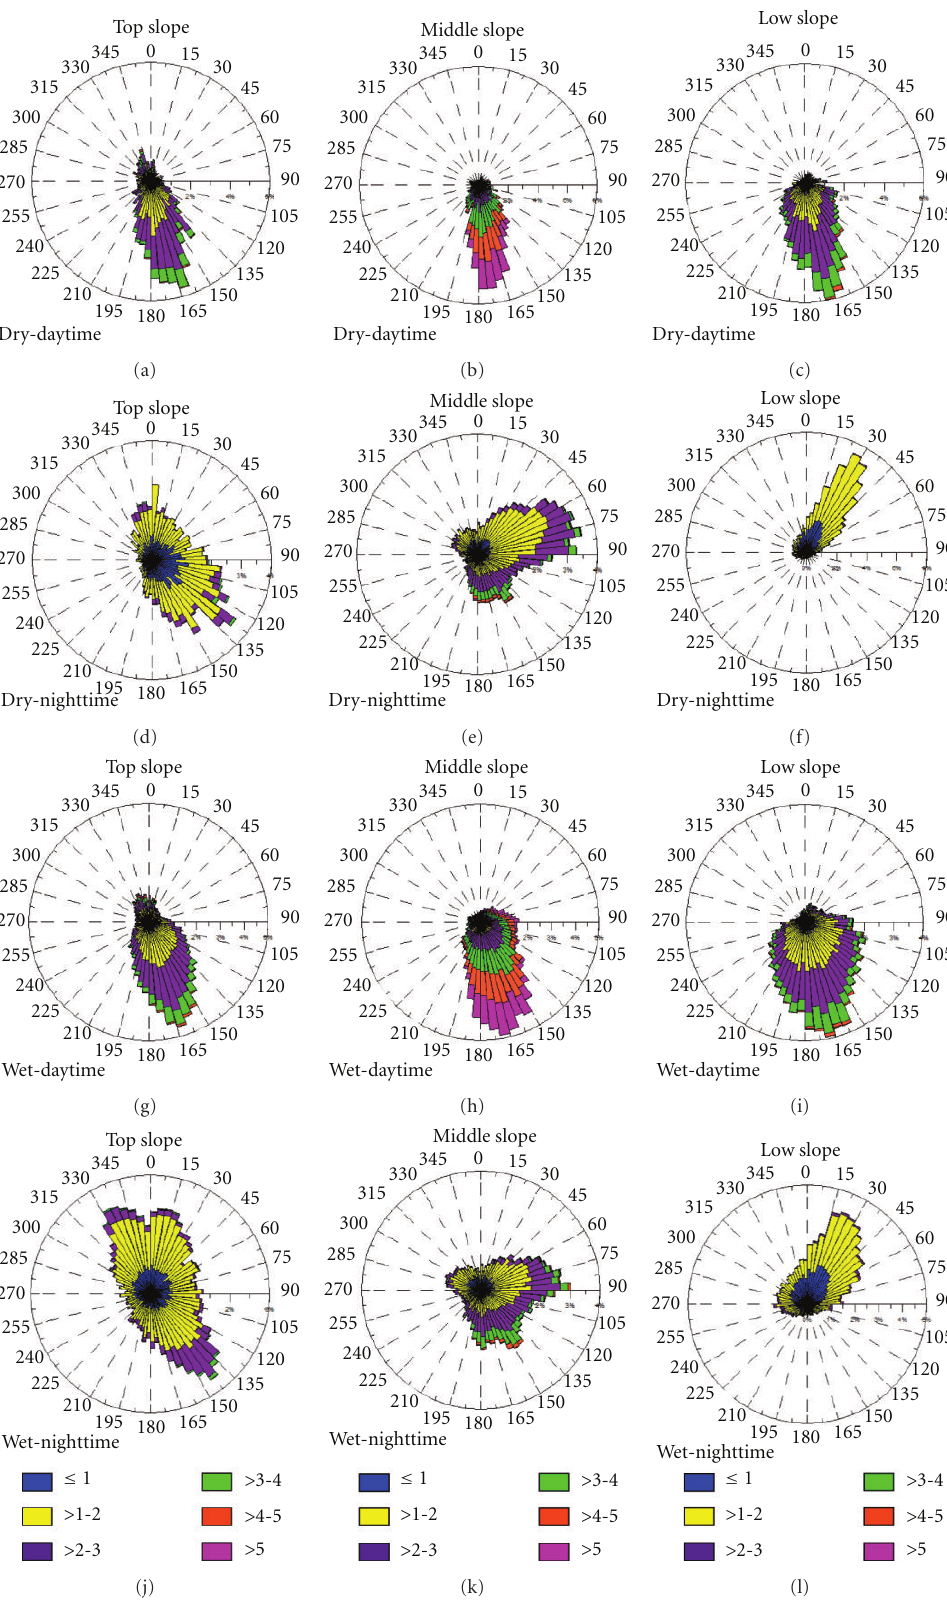
Figure 12: Frequency distribution of the wind speed and direction in the subcanopy array (2m above ground level—a.g.l) on the microbasin south face slope area at DRAINO horizontal array system (see Figure 4). For dry (a–f) and wet (g–l) periods from the year 2006, during day- ((a), (b), (c), (g), (h), (i)) and nighttime ((d), (e), (f), (j), (k),